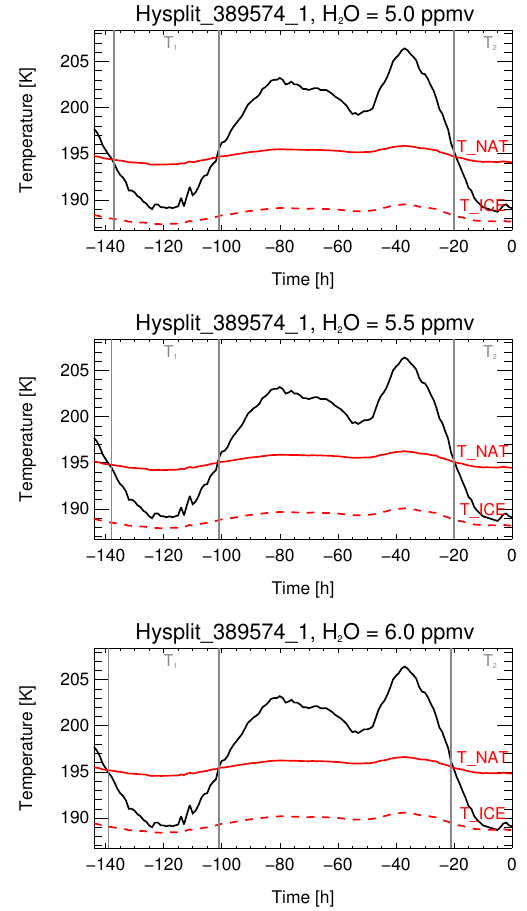
Figure 3. Temperature history of the back trajectory calculated with HYSPLIT based on the PSC measured by CALIPSO on 26 Febru- ary 2011 (back trajectory started at 20km at 00:00UTC). Top: for a typical H 2 O mixing ratio of 5ppmv in the polar lower strato- sphere, middle: for an H 2 O enhancement of 0.5ppmv (5.5ppmv), bottom: for an H 2 O enhancement of 1ppmv (6ppmv). The NAT existence temperature T NAT and ice formation temperature T ice are given as solid and dashed lines, respectively. Temperatures drop be- low the NAT formation temperature at time periods t = − 140 to − 100h and t = − 20 to 0h. The temperature ranges during these time periods are denoted by T 1 and T 2 , respectively (grey solid